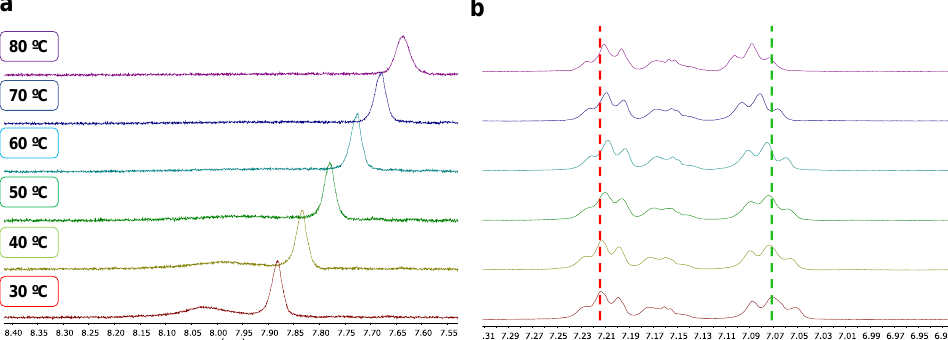
Figure 4. Partial 1 H NMR (500 MHz, DMSO- d 6 ) spectra for the variable-temperature experiments of 6b (3 mM, H 2 O:DMSO, 20:80); ( a ) amide group region and ( b ) aromatic region. A different scenario was observed on behalf of the signals for the aromatic